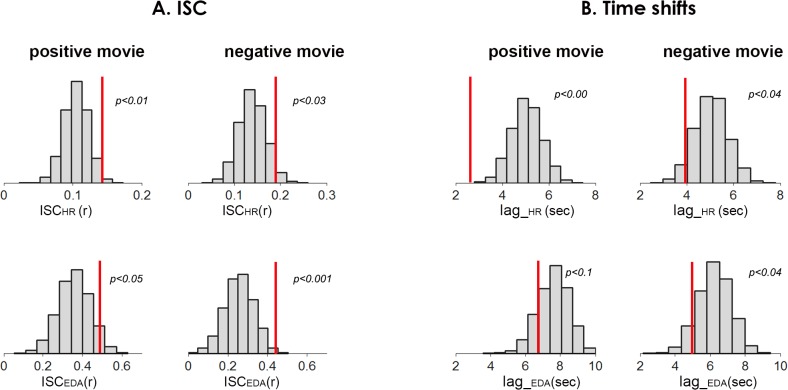
The effect of co-presence on autonomic ISC.
A. Control (H0) distributions (not co-present) and the experimental means (co-present, dashed lines), for both autonomic measures (ISCEDA, ISCHR) and for both emotional movies. H0 distributions represent movie-driven ISC of ANS signals. As can be seen in the figure, the experimental group-wise ISCs fall in the right tail of the control distributions, indicating the positive effect of co-presence on synchronization of participants’ autonomic activity. B. Time shifts in ANS synchronization: we assessed whether the ANS signals of co-present individuals were more tightly linked in time. Figure presents the control (H0) distributions and the experimental means (dashed lines) of the time lags in which two ANS signals exhibited maximal ISC. As can be seen in the figure, the time shifts in ANS synchronization of the co-present participants were significantly smaller in three out of four ANS measures. Lag_EDA in the positive movie showed a trend towards significance.